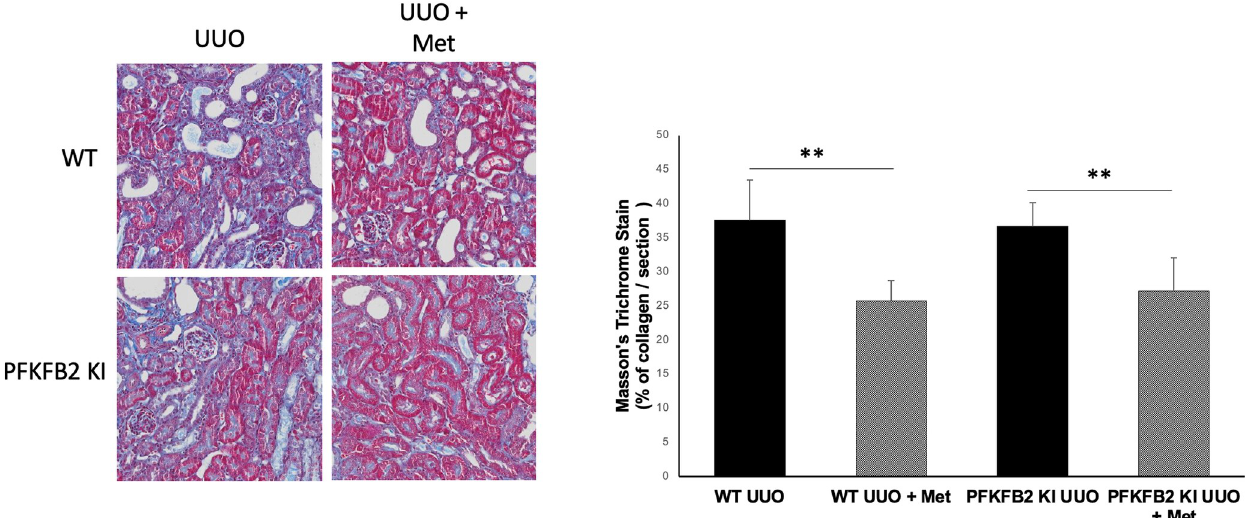
Fig 3. Masson’s trichrome staining of collagen deposition as a marker of fibrosis for WT and PFKFB2 KI UUO kidneys ± metformin showing representative sections (A) with corresponding quantification (B). Mice treated with metformin had less evidence of collagen deposition per section compared to their untreated counterparts for both WT ( �� p = 0.0025) and PFKFB2 KI mice ( �� p = 0.0094). There was no significant difference between WT and PFKFB2 groups. Quantification was performed from a set of images that provided coverage of the whole kidney cortex. Mean +